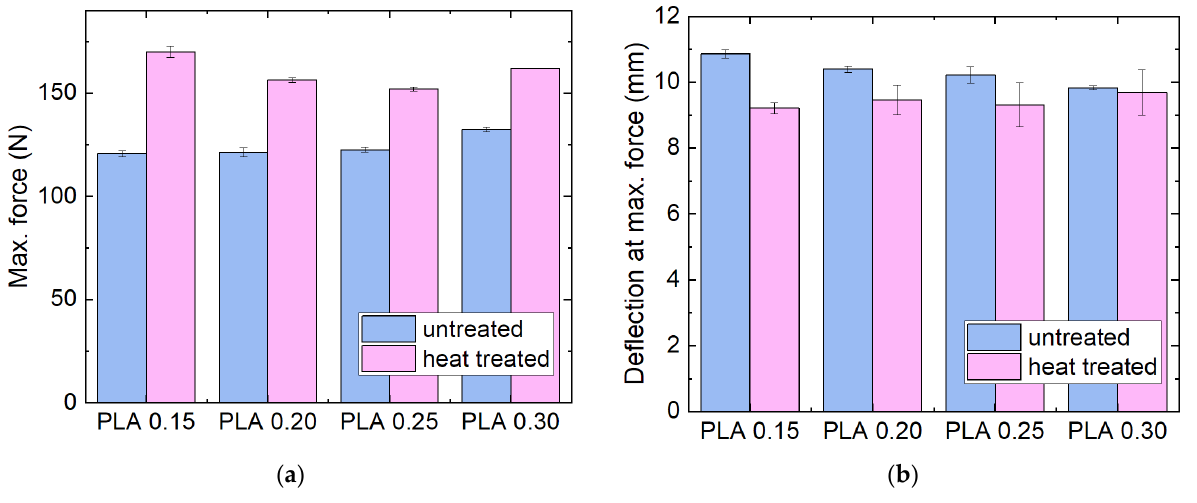
Figure 5. Mechanical properties of the PLA samples with different layer heights, as printed and after heat treatment at 100 °C: ( a ) maximum force; ( b ) deflection at maximum force in 3-point bending tests.